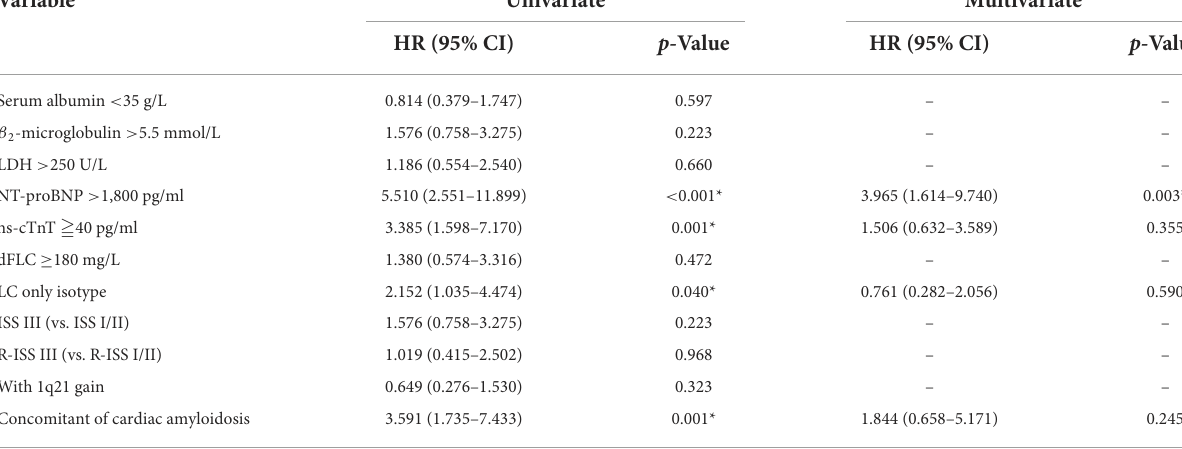
TABLE 3 Univariate and multivariate survival